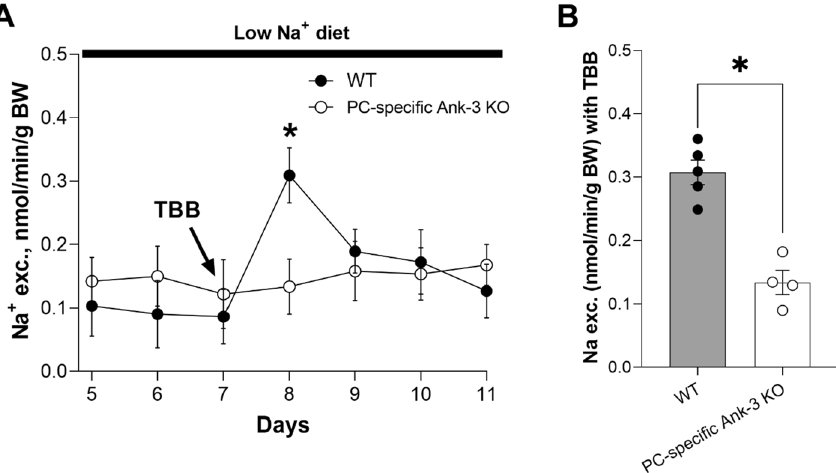
Figure 6. Ank-3 is downstream of CKII with respect to regulation of ENaC. ( A ) Summary graph showing Na + excretion as a function of time in WT mice (white circles, where n = 5 independent trials with three mice per trial) and PC-specific Ank-3 KO mice (black circles, where n = 4 independent trials with three mice per trial) before and after treatment with TBB on day 7 of a sodium free diet. TBB was introduced through a single intraperitoneal injection at 125 µg/kg in 100 µL of 10% DMSO/sterile water. Urinary sodium excretion (U Na V) was measured in 24 h intervals. *P < 0.05 vs. KO mice and before treatment. ( B ) Summary graph showing the effects of TBB on Na + excretion (on day 8) in WT (black circles, gray bar) and PC-specific Ank-3 KO mice (white circles, white bar). TBB increased Na + excretion significantly more in WT mice compared to PC-specific Ank-3 KO mice, where it had no effect. *P < 0.05 vs. KO